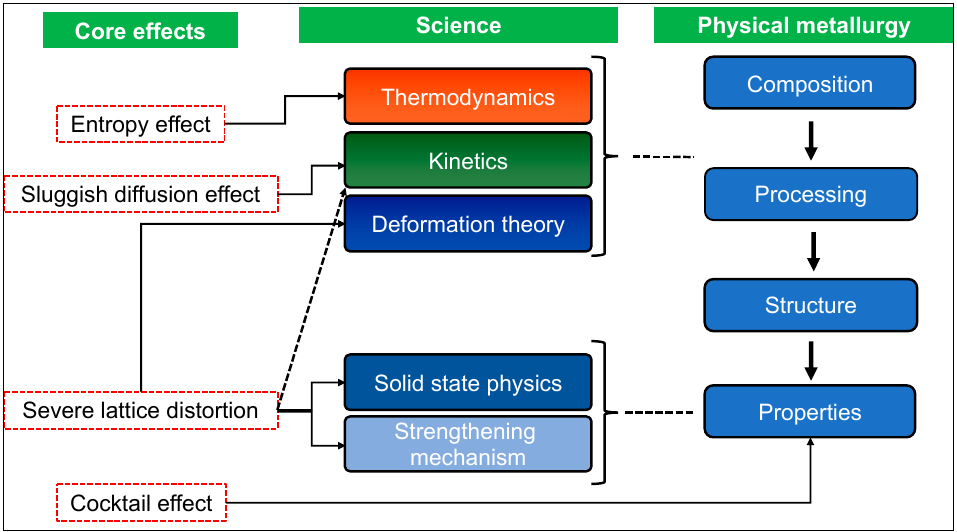
Figure 10. The interrelationship between core effects, the science, and physical metallurgy of CCAs. High configurational entropy and enthalpy of mixing: The high entropy and enthalpy of mixing effects deviate from the Gibbs phase rule stabilizing phase proportions. This contributes to the observed properties, which are not common to most conventional one- or two-principal element-based materials. Increasing the constituent elements lowers the Gibbs free energy of the system, which outweighs the driving force for detrimental intermetallic phases and restricts their formation. Thus, most CCAs/HEAs should have simple and stabilized solid-solution phases. Configurational entropy and the enthalpy of mixing are related by Boltzmann’s relation (Equation